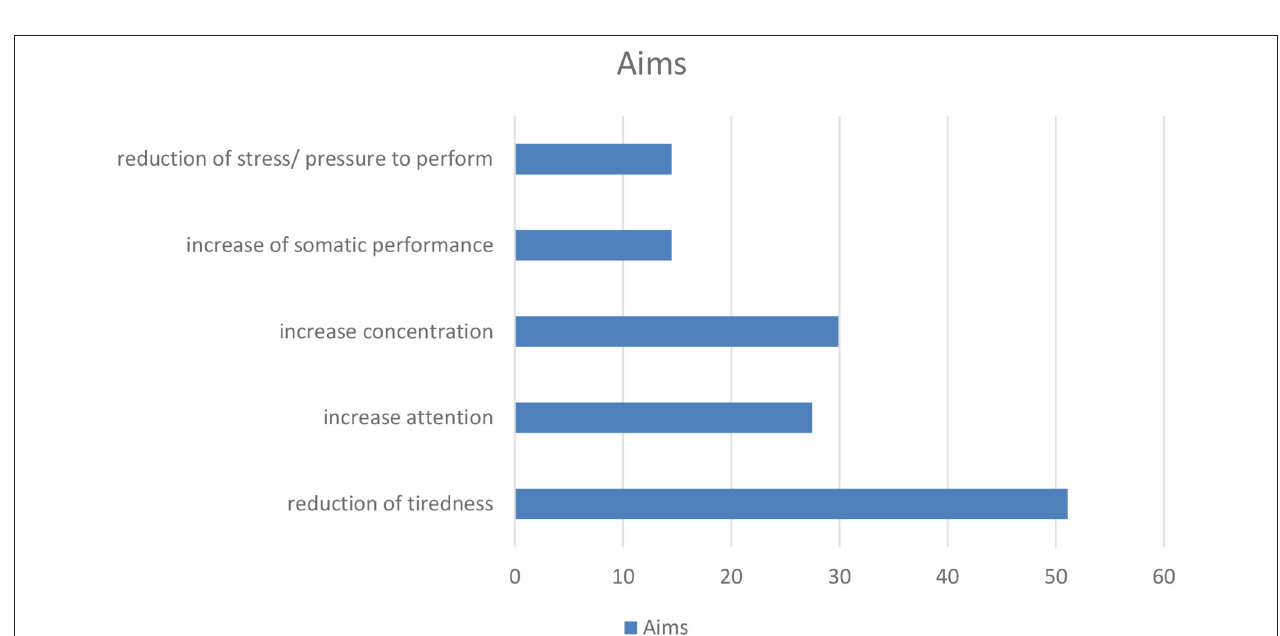
FIGURE 2 | (According to Table 6 ): Aims for the use of methylxanthines for neuroenhancement.